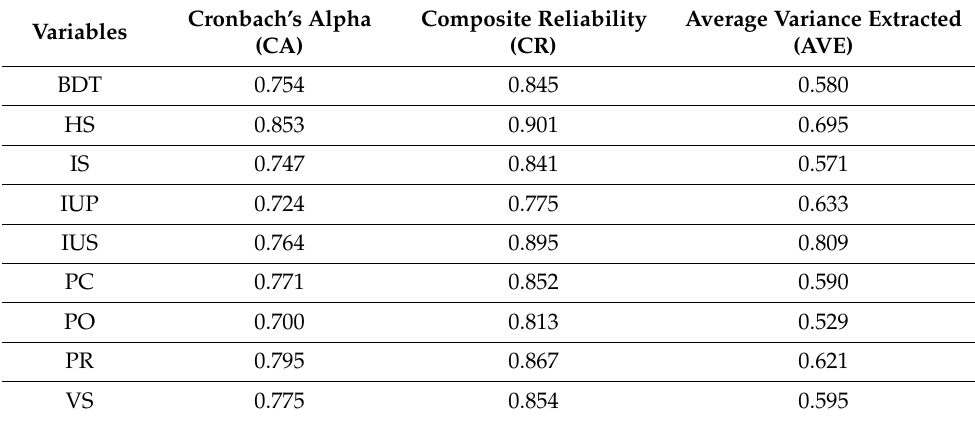
Table 2. Construction of the reliability and validity of the reflective